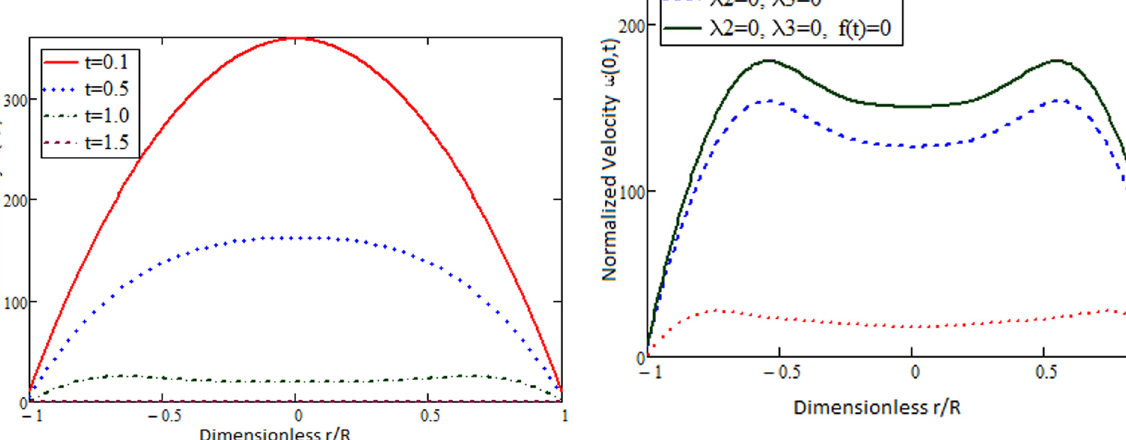
Figure 4: Comparative behavior of Maxwell fl uid ( with ( ) = f t 0